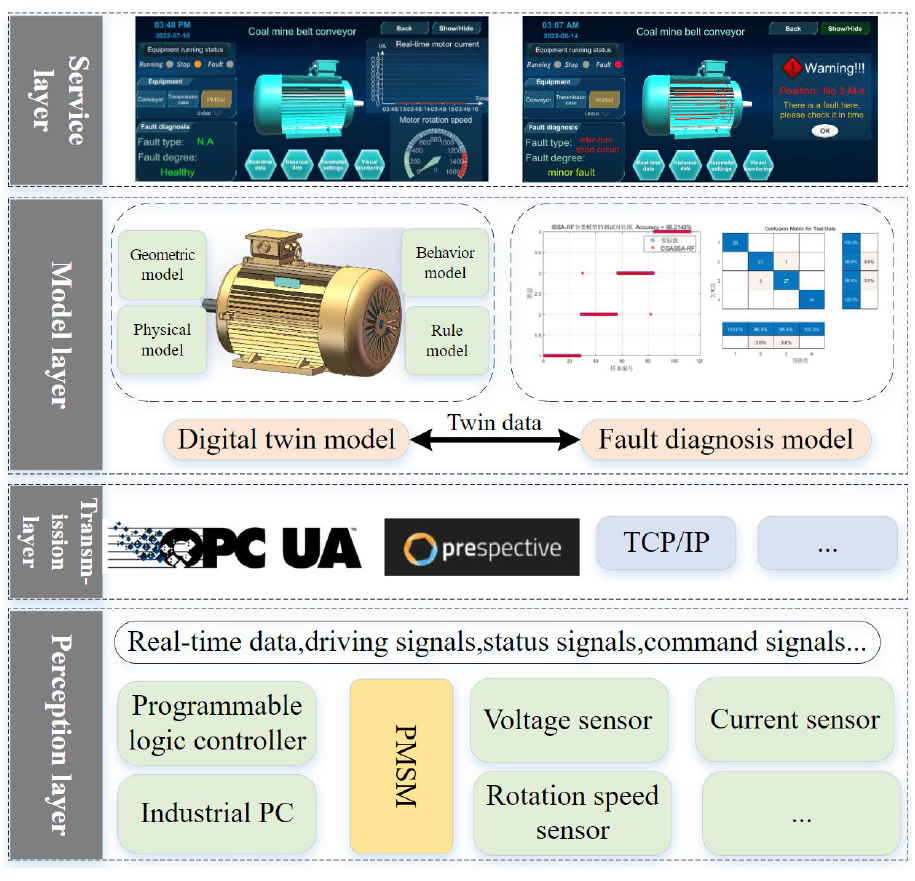
Figure 2. Permanent Magnet Synchronous Motor Fault Diagnosis Digital Twin